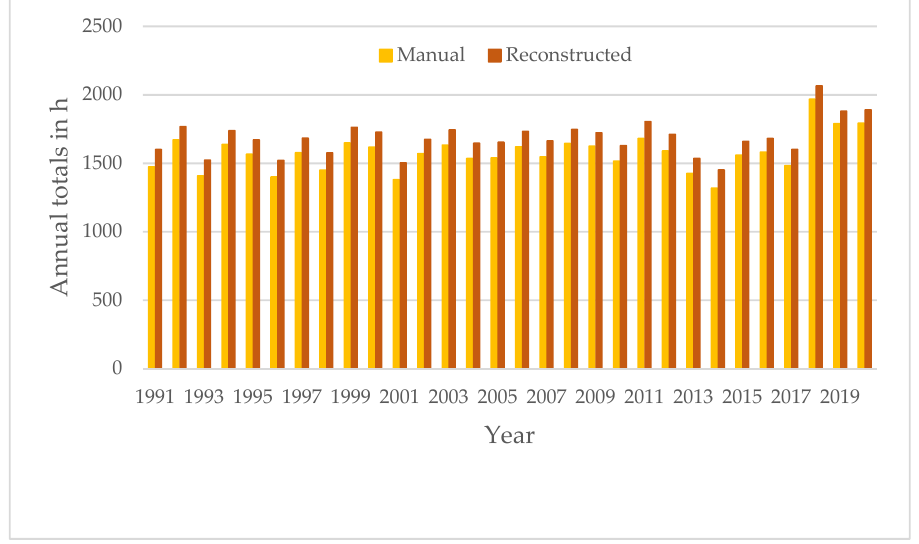
Figure 7. Manual and reconstructed multi-year series of annual sunshine duration sums in Borucino, 1991–2020.